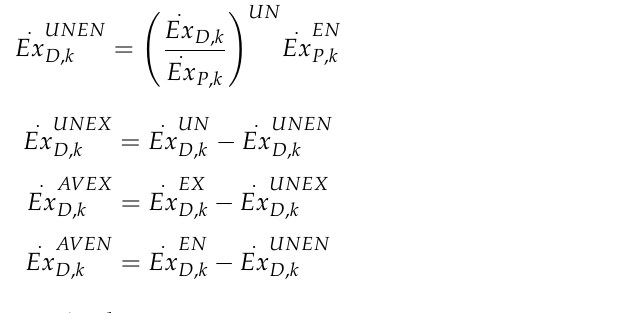
Figure 4. Exergy destruction splitting within a component for advanced exergy analysis. The value of the unavoidable-exogenous, unavoidable-endogenous, avoidable-exogenous, and avoidable-endogenous exergy destruction for the kth component is calculated as indi- cated in Equations (32)–(35)